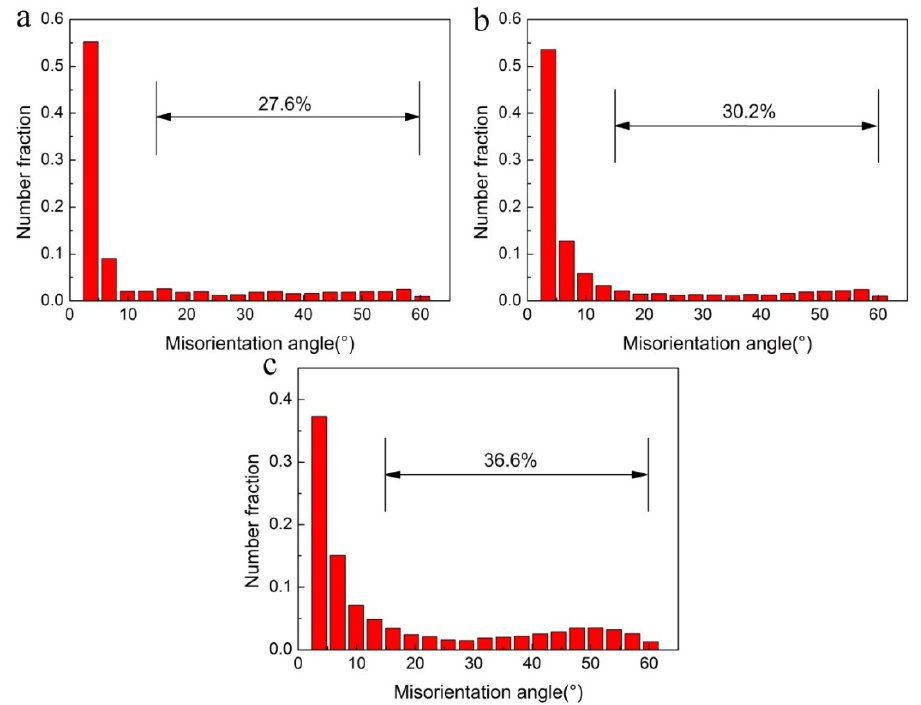
Figure 12. Misorientation angle distributions of Al-Zn-Mg-Cu alloy under various deformation conditions: ( a ) 380 ° C/0.1 s − 1 , ( b ) 410 ° C/0.1 s − 1 , ( c ) 440 ° C/0.01 s − 1 .